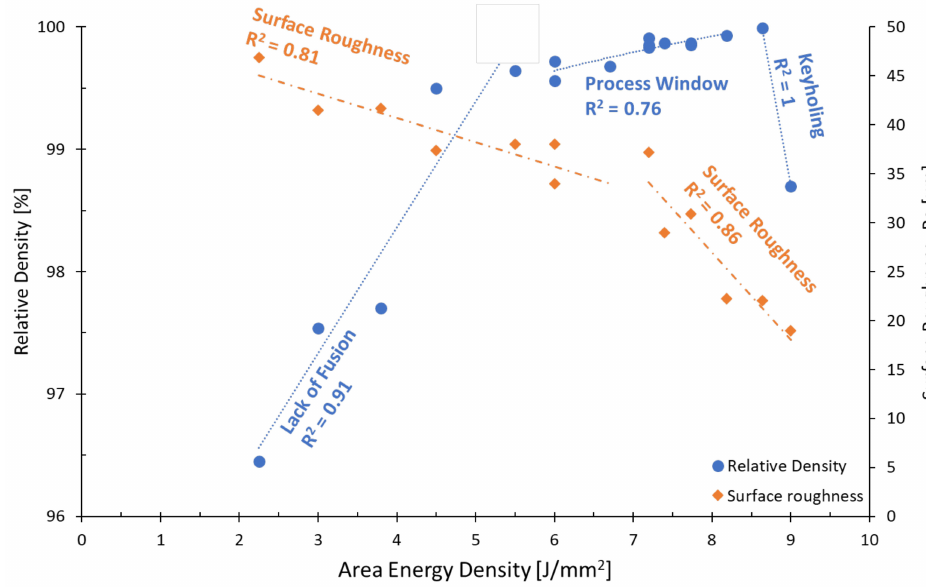
Figure 1. Relative Density and Surface Roughness vs. Area Energy Density of EBM Cu